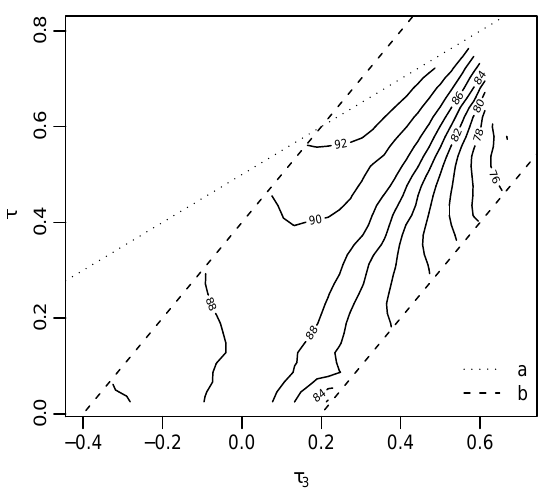
Fig. 6. L-CV–L-CA diagram analogous to Fig. 1. The contour lines give the average coverage frequency of the 90% confidence inter- vals when considering 10000 samples of length 30, extracted from the five considered parent distributions (GEV, P3, LN, GP and GL), for each of the grey points in Fig. 1. The log-Student t distribution of Eq. (14) with corrected parameters (Eqs. 16 and 17) provides the estimator for the confidence intervals for τ